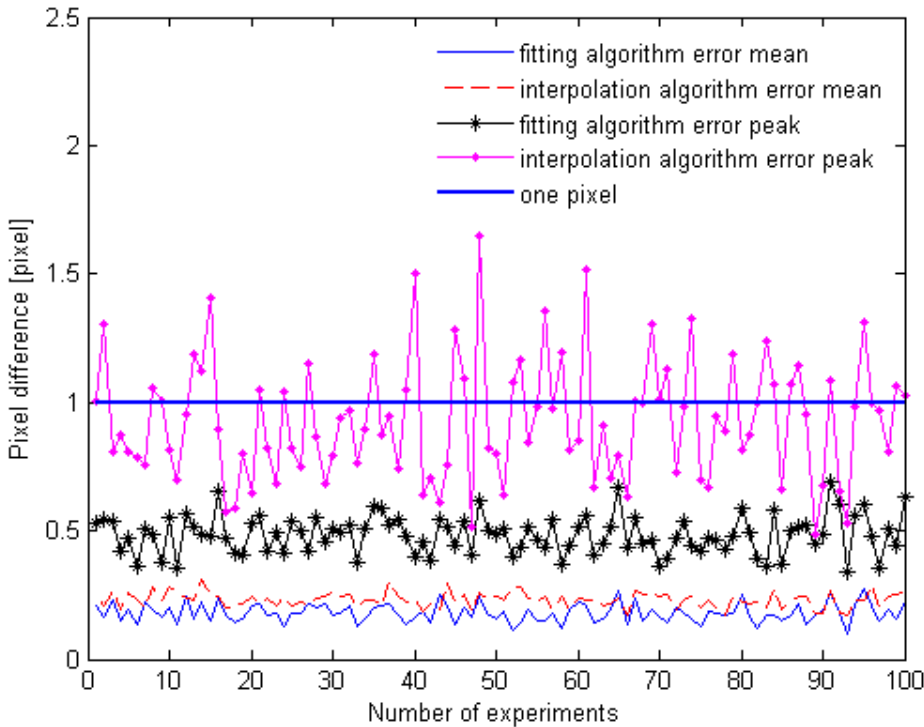
Figure 17. Pixel estimation error results after repeated experiments with different algorithms.